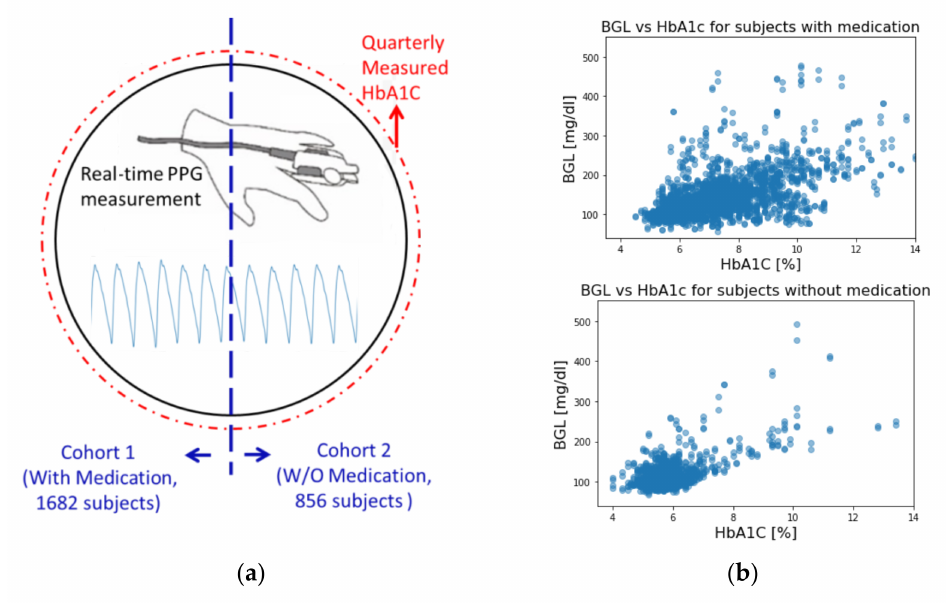
Figure 1. ( a ) Visual representations of this study. ( b ) Correlation of HbA1c and BG level for subjects with and without